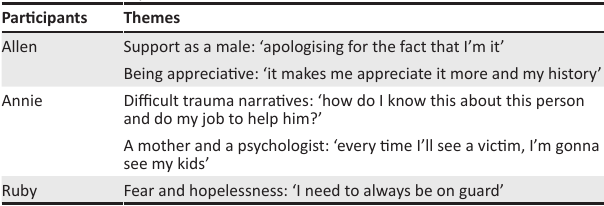
TABLE 1: List of super-ordinate